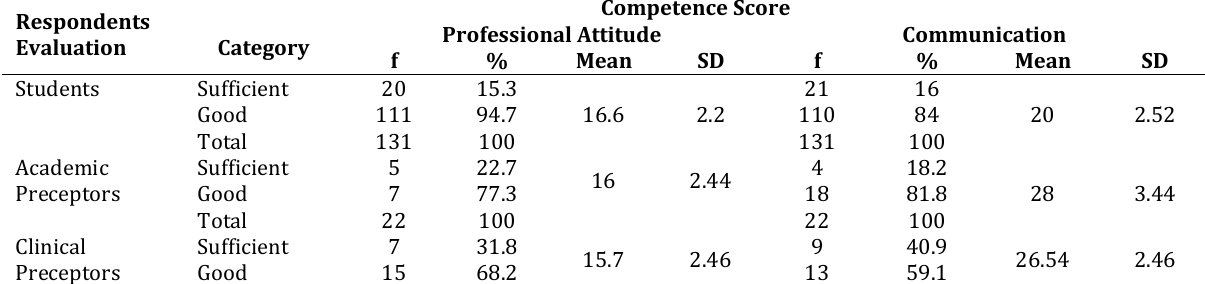
Table 3. Evaluation of Professional Attitudes and